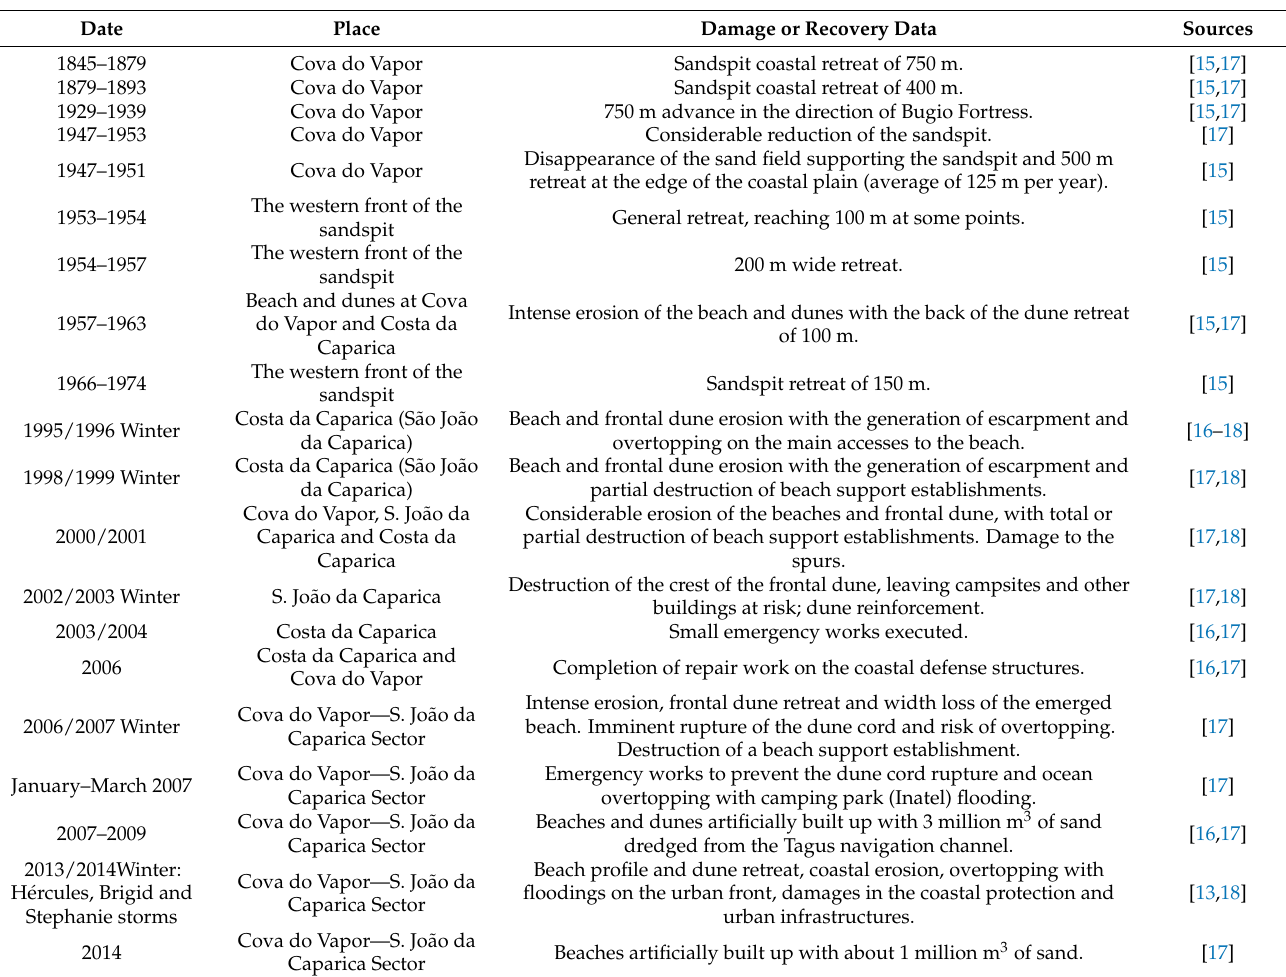
Table 2. Coastal changes—literature